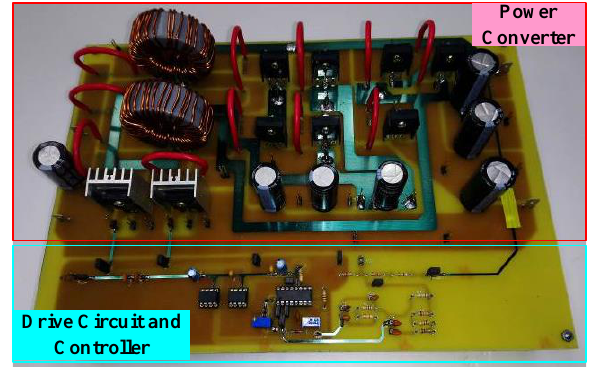
Figure 20. Photograph of the laboratory prototype.